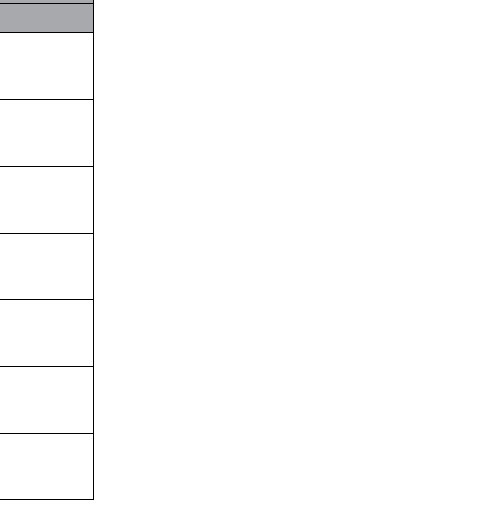
φ ′ ( 0 ) versus flow −